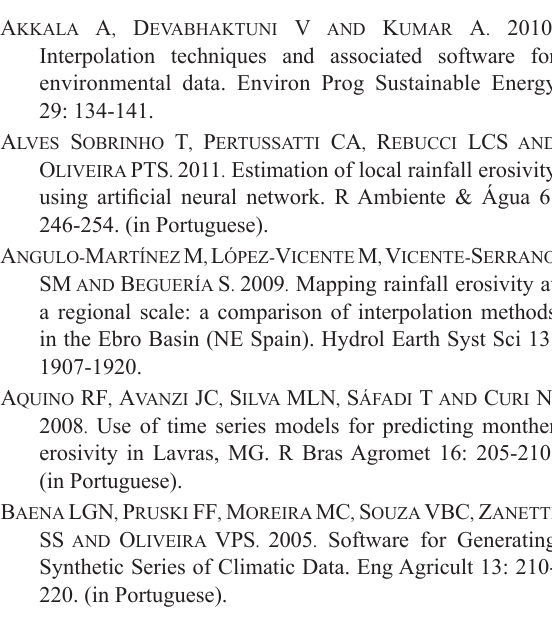
Figure 2 - Spatial distribution of the annual EI equation and interpolated using the developed